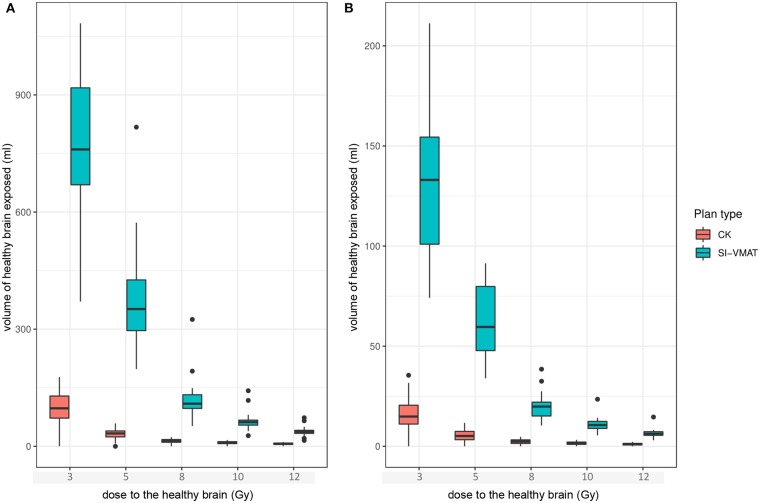
Dose exposure of the healthy brain for different dose levels between 3 and 12 Gy to represent dose falloff for all targets within one treatment plan (A) or for the individual target (B); boxes represent Q1–Q3 around the median. CK, CyberKnife; SI-VMAT, single-isocenter volumetric modulated arc therapy; VX
Gy, volume receiving X Gy.